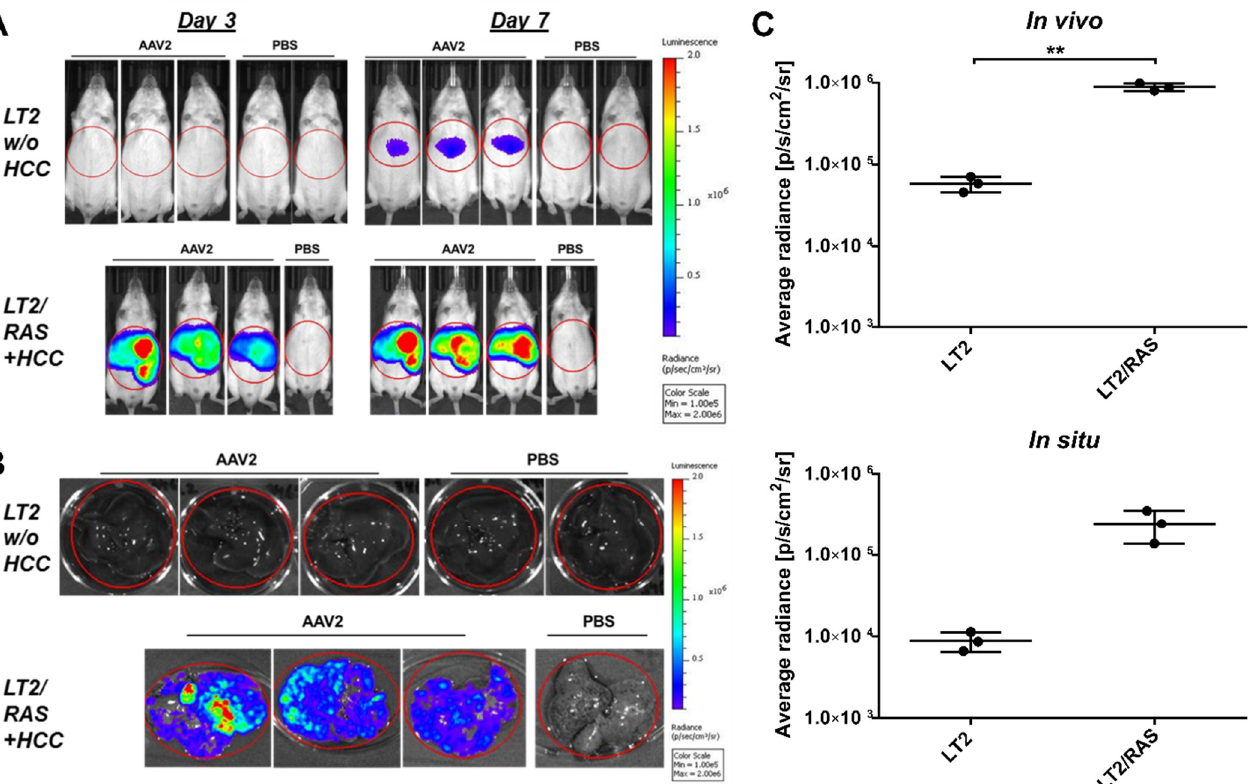
Figure 6. Transgene expression of AAV2 vector in liver and HCC in LT2/RAS HCC mice and controls. Indicated animals were i.v. injected with scAAV2.SFFV.Fluc and i.p. injected with D-luciferin 5 min before IVIS measurement. Vector dose: 1 × 10 11 particles per animal. IVIS measurements of healthy LT2 mice compared to tumor-bearing LT2/RAS HCC mice showing the AAV2 vector-mediated luciferase activity ( A ) in vivo on days 3 and 7 after vector injection and ( B ) of isolated liver samples (in situ) on day 7 after vector injection. Luciferase activity quantified as average radiance (p/s/cm 2 /sr) of the luminescence signal, scale bars: Average radiance in p/s/cm 2 /sr, min = 1 × 10 5 , max = 2 × 10 6 ; ( C ) IVIS quantification of average radiance in vivo and in situ on day 7. Data are shown in log 10 -scale as the mean average radiance with SD. Statistics: Unpaired two-tailed t -test with Welch’s correction (** p < 0.01). N = 3 animals with AAV treatment and n ≥ 1 with PBS